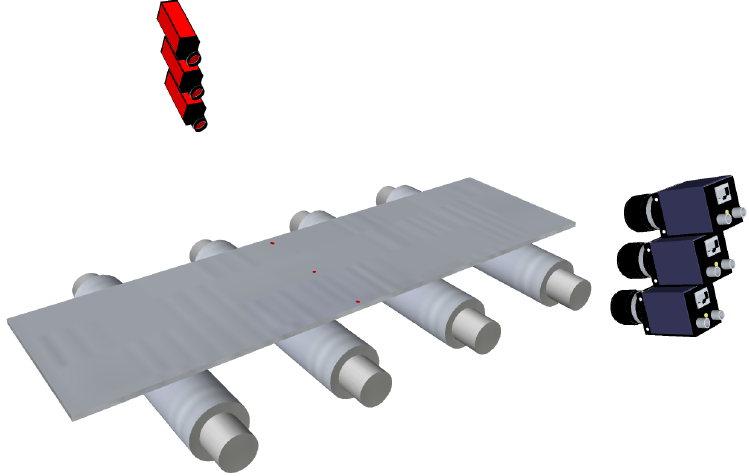
Figure 7. Flatness sensor based on active optical triangulation. Three discrete laser points are projected onto the product surface and imaged using linear cameras. Cameras and laser projectors may be installed on motorized stands or combined with sets of mirrors to track lateral displacements of the rolled product while